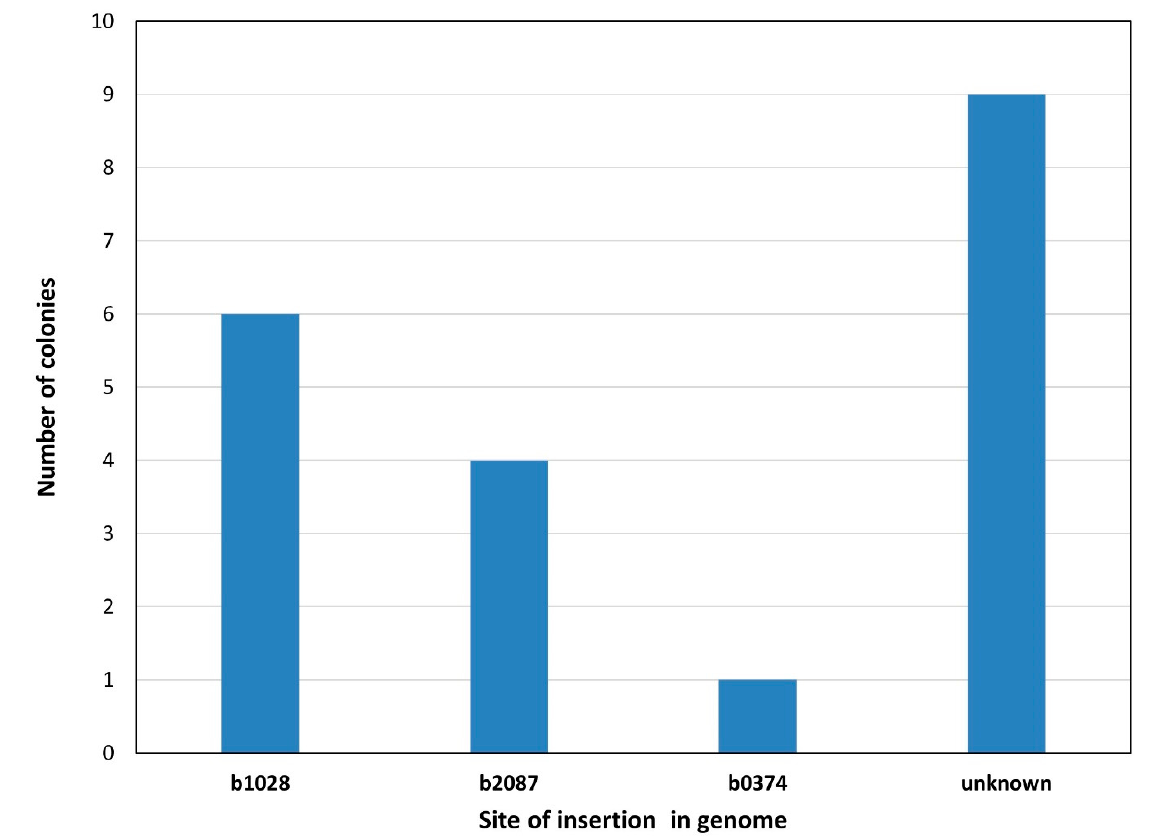
Figure 3. Result of recombineering experiments integrating the vioABCDE _KmR cassette into a chromosomal IS 3 of E. coli MDS16. The number of colonies harboring a PCR-verified integration at either of three loci (b1028, b2087 or b03741) or displaying no PCR-verified integration (“unknown”) are shown. An exemplary experimental outcome is displayed from a set of two similar experiments.